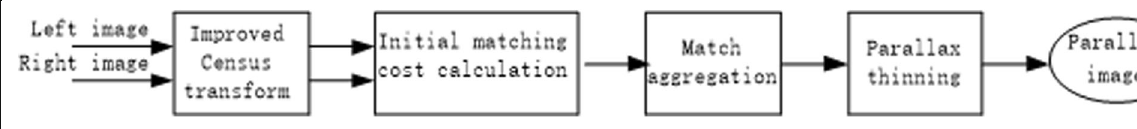
Fig. 4 Flow chart of the algorithm